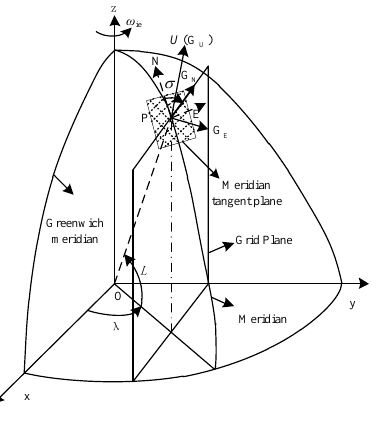
Figure 1. Definition of the grid frame.